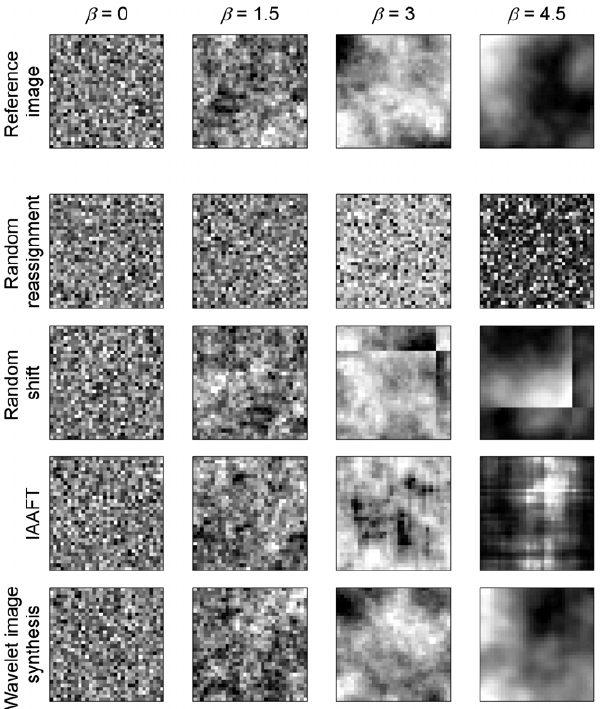
Figure 1. Examples of surrogates for images with increasing degree of autocorrelation. The first row features particular simulations of fractal patterns (fractional Brownian field) generated by Fourier synthesis [27] for four degrees of autocorrelation (from short- to long-ranged as indirectly quantified by the b parameter). The following rows (2 to 5) display one particular random realization (i.e. re- simulation) of each of these fractal patterns according to four surrogate producing methods (random reassignments, random shifts, iterative amplitude adjusted Fourier transform (IAAFT) and wavelet-based energy synthesis,